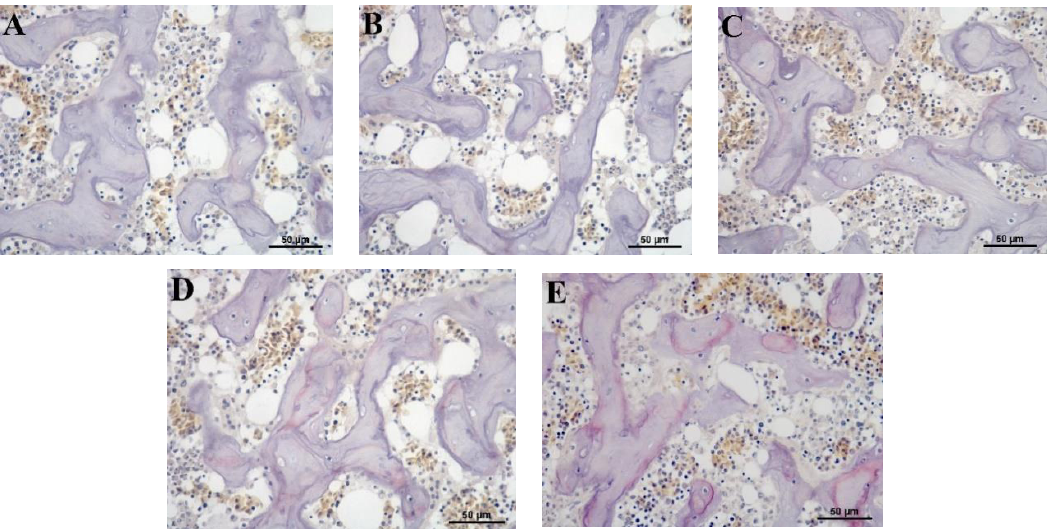
Figure 4. Photomicrographs of hematoxylin and eosin (H & E) stained (100 × magnification, bar = 100 μm, n = 6) longitudinal sections of the tibia showing the decrease in bone volume observed in Cd (60.67 mg/kg group) exposed animals ( B ) as compared to controls (0.47 mg/kg Cd group) ( A ). ( C ) trabecular number; ( D ) trabecular width. Values are presented as the mean ± SE ( n = 6). a–b Means with different superscript letters are significantly different ( p < 0.05).